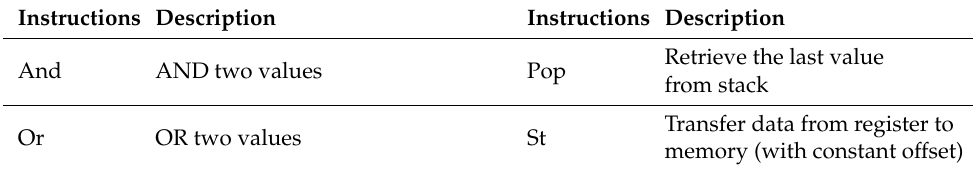
Figure 8. The platform of Figure 7.